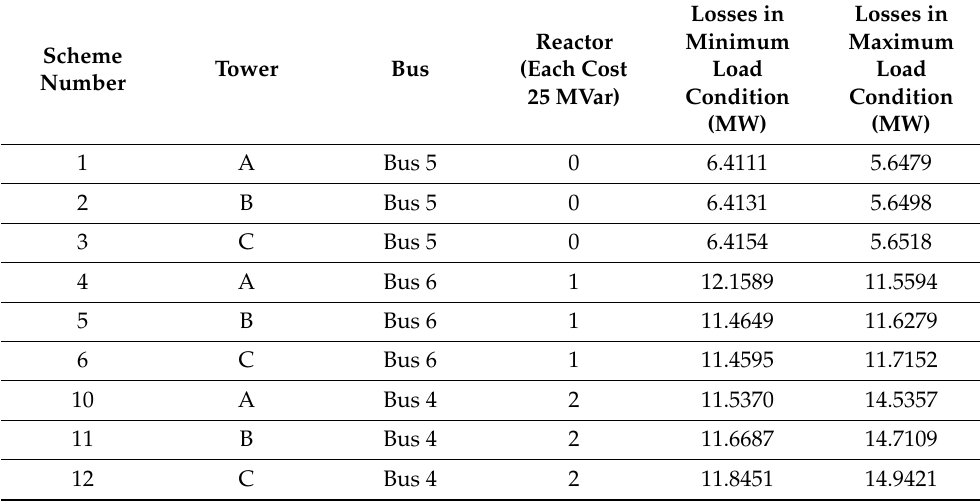
Table 8. Comparison of different access bus